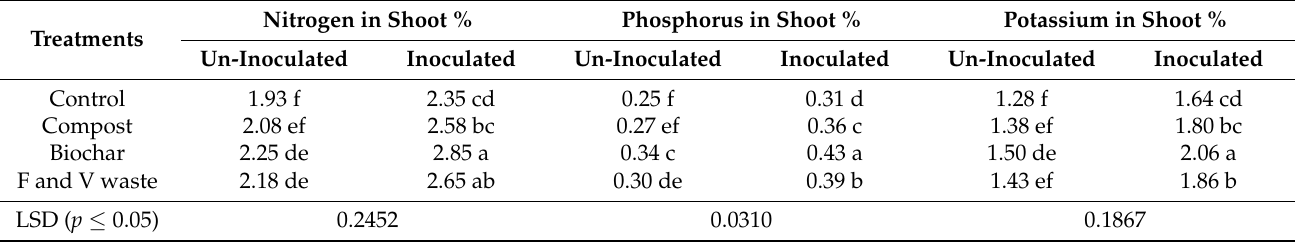
Table 4. Effect of compost, biochar, fruit and vegetable waste (F and V waste) and Bacillus subtilis SMBL 1 on N, P, K in shoot of okra.